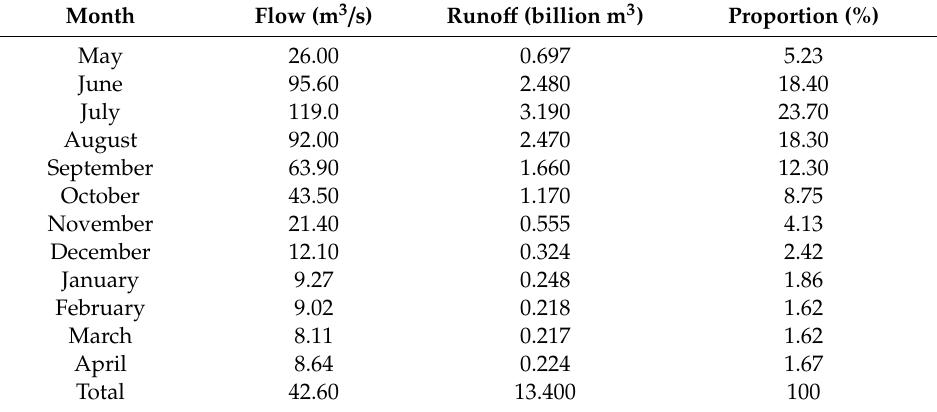
Table 1. Statistics of annual flow and runo ff in the Maling dam